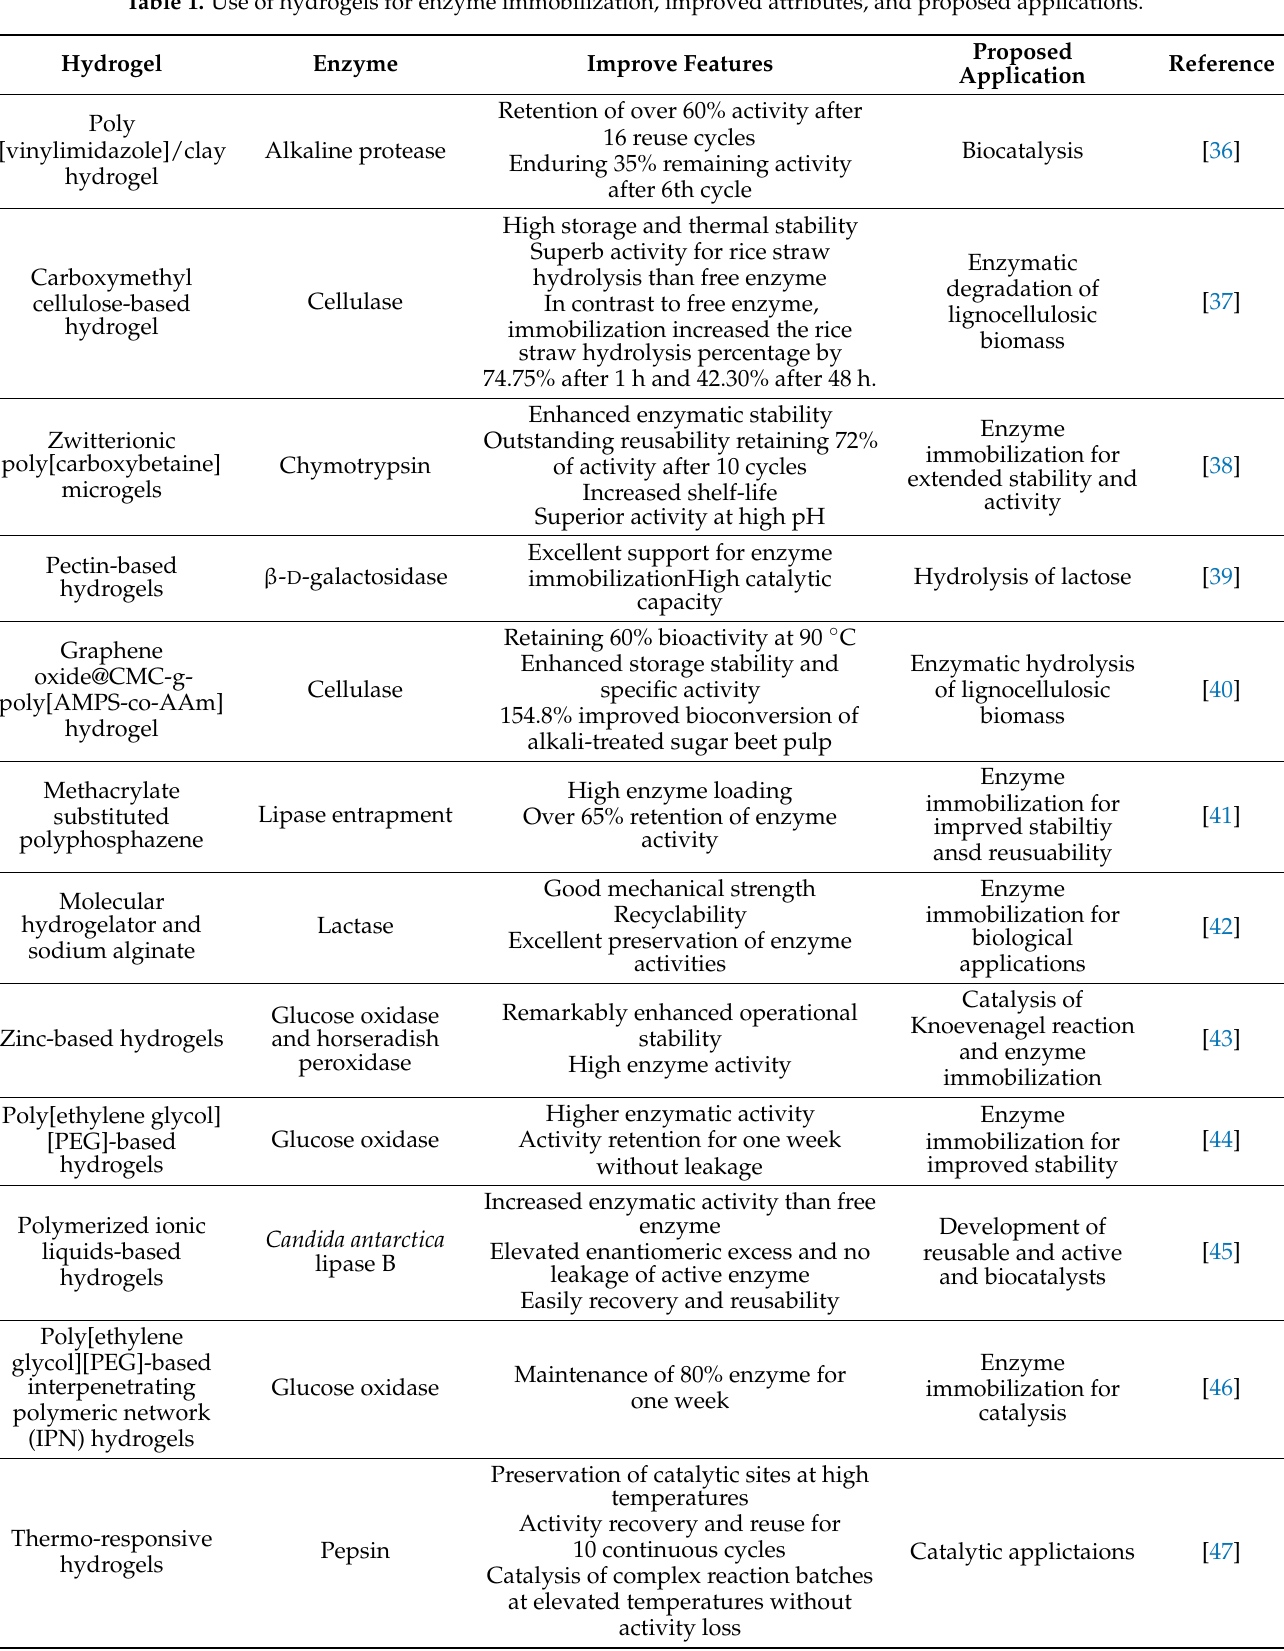
Table 1. Use of hydrogels for enzyme immobilization, improved attributes, and proposed applications.